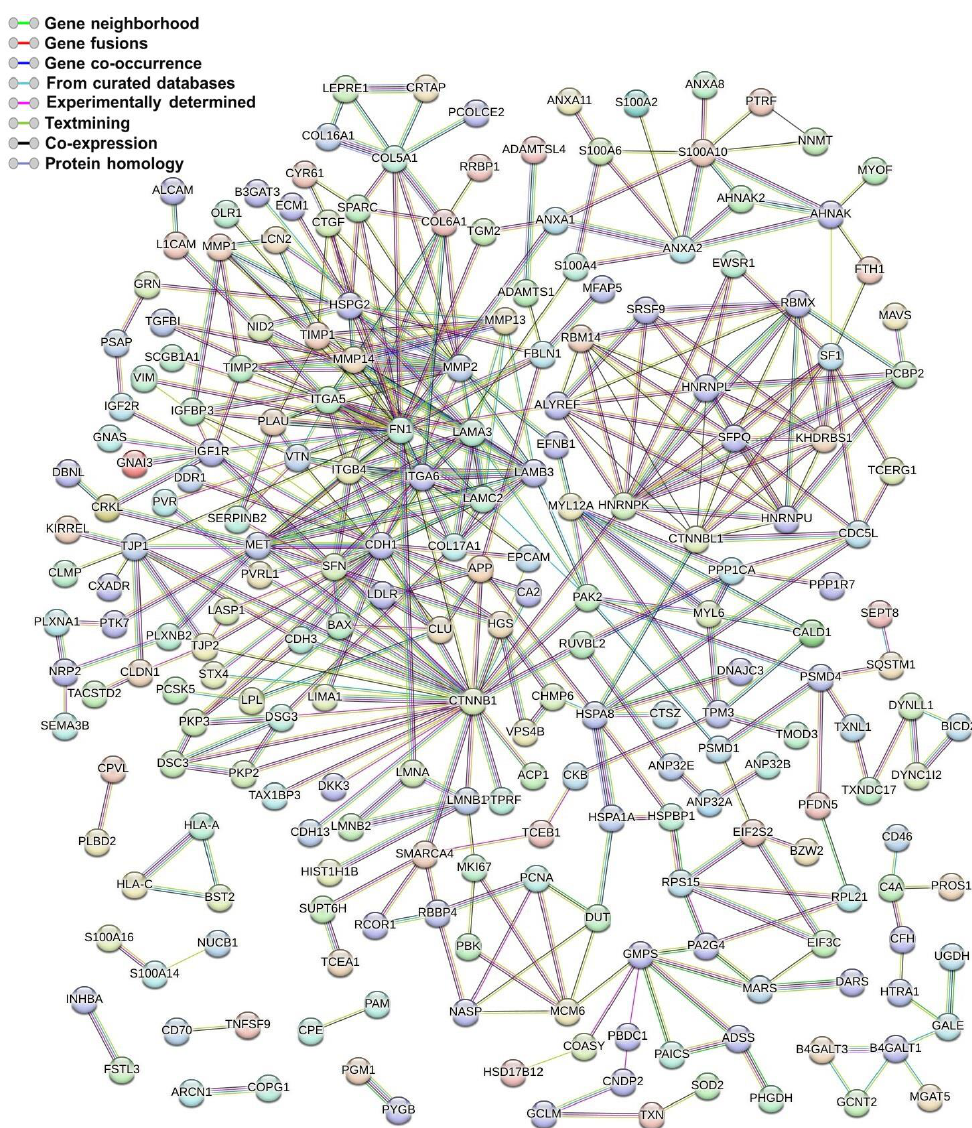
Figure 6. Protein–protein interaction (PPI) network of differentially expressed proteins from cervical cancer EVs. The network shows the 218 proteins that have at least 1 functional connection. The network nodes represent the proteins, and the edges represent the protein–protein associations. The line color connecting the nodes indicates the type of interaction, as shown in the top left corner.